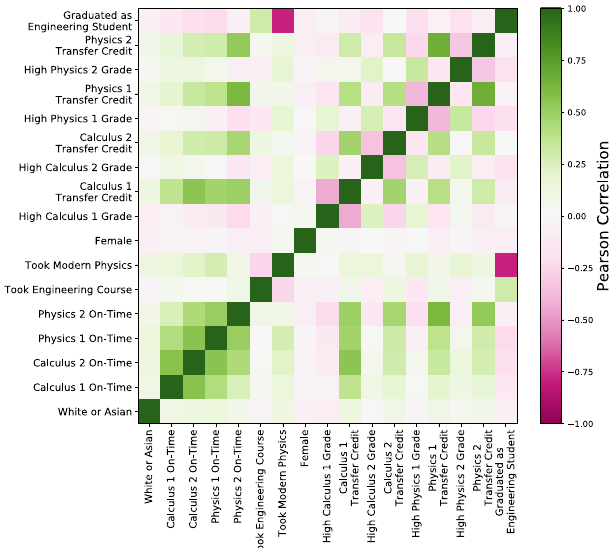
FIG. 2. Pearson correlation matrix for features in the main